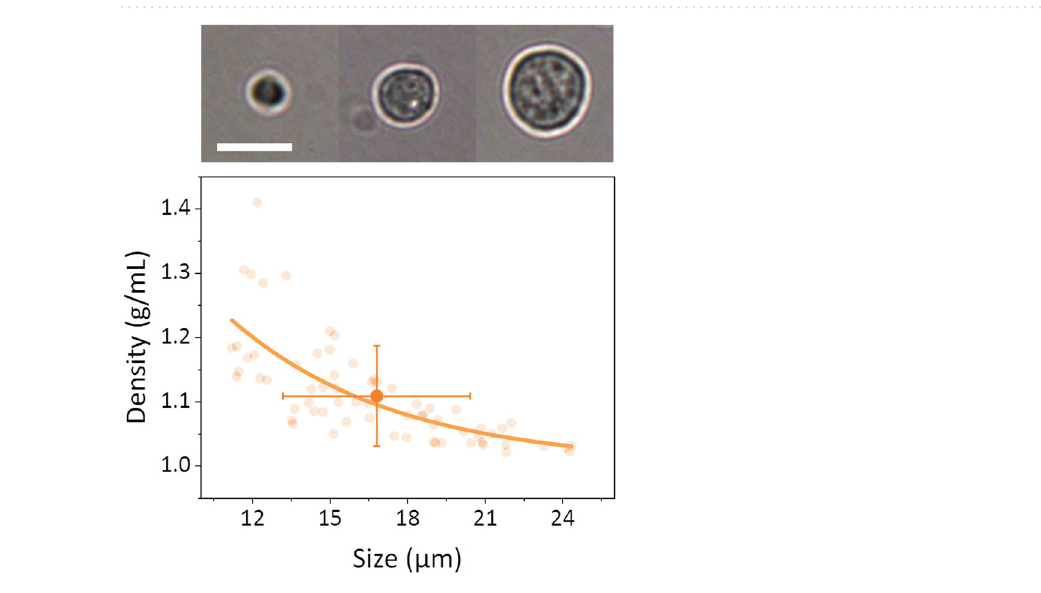
Figure 5. Cell mass density experiments. Up. Optical micrograph of individual MCF-7 cells of different sizes. The scale bar is 25 μm. Down. Experimental measurements of the mass density of individual MCF-7 human epithelial breast cells (orange symbols). The solid line represents a fitting of the experimental values, showing the size dependency of the measured